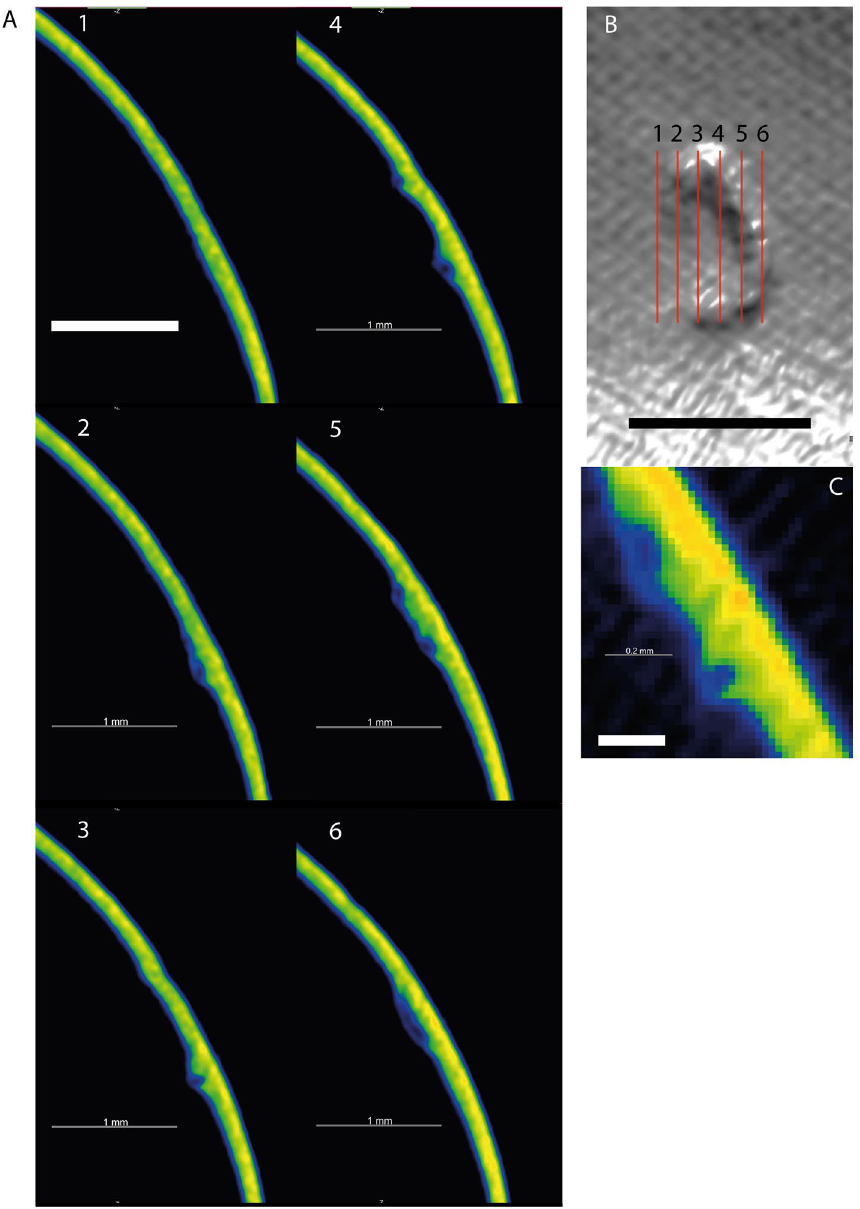
Figure 3. ( A ) Six sequential slices through the encapsulation and surrounding shell. The complete encapsulation, and tubular nature of the structure can be seen in slices 2–6. Slices are coloured according to density—warmer colours indicate higher density. Slice locations are shown in the upper right ( B ). ( C ) Close up slice shown as raw pixel data (non-interpolated). Scale bar in A + B = 1 mm, scale bar in C = 0.2